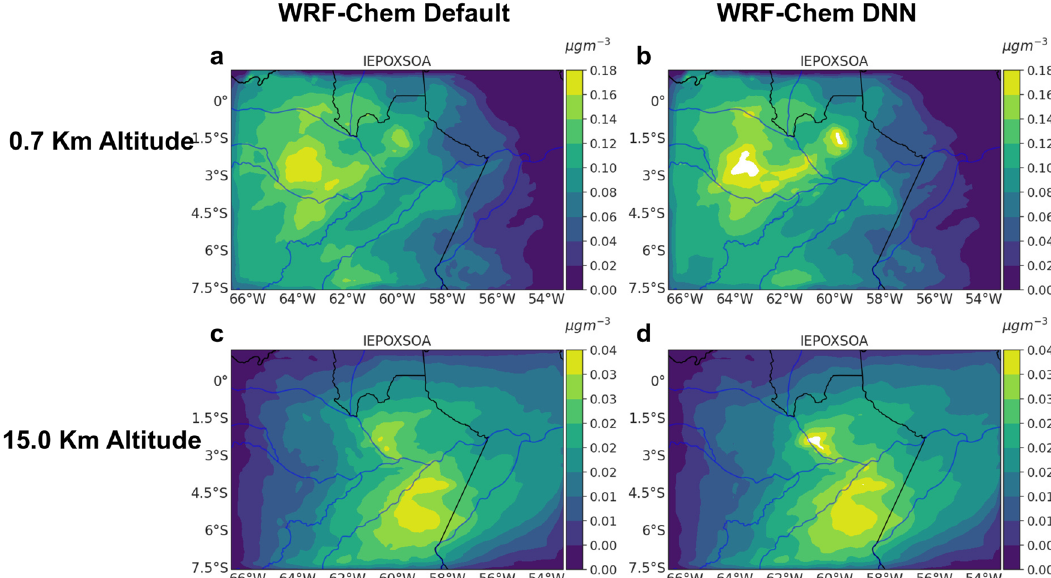
Fig. 3 Comparison of WRF-Chem default and WRF-Chem DNN model simulations at two different altitudes. Simulated time-averaged IEPOX-SOA concentrations over horizontal cross sections at ( a , b ) 0.7 km altitude. ( c , d ) 15.0 km altitude.